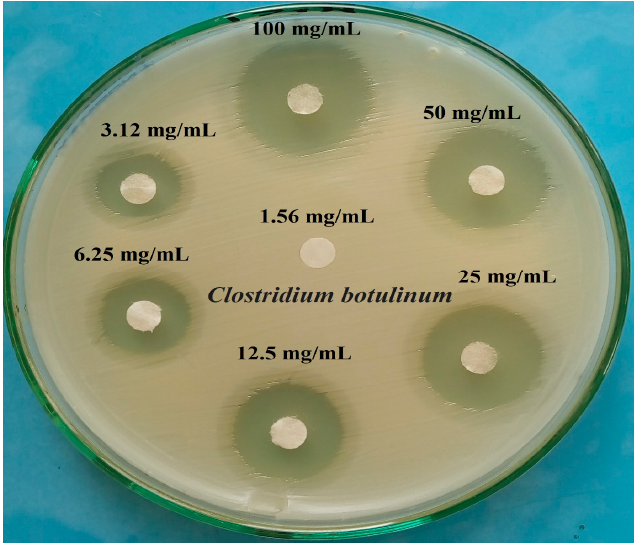
Data represented are the means of triplicates ± standards error of means. a, b, and c : data in the same row followed by different superscript letters differ significantly ( p < 0.05). ND: Not detected.